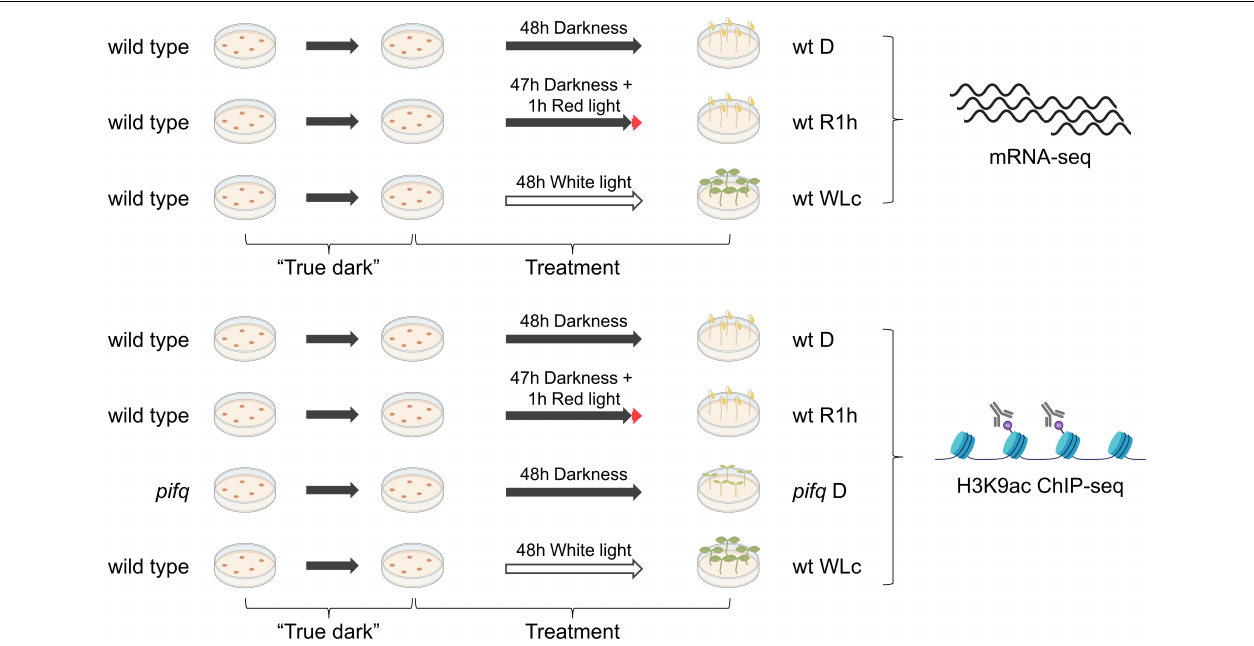
FIGURE 1 | Experimental setup. Wild type or pifq seedlings were grown in “true dark” conditions and treated for 2 days before sample collection and processing for mRNA- or H3K9ac ChIP-sequencing (see section “Materials and Methods” for detailed experimental procedures).